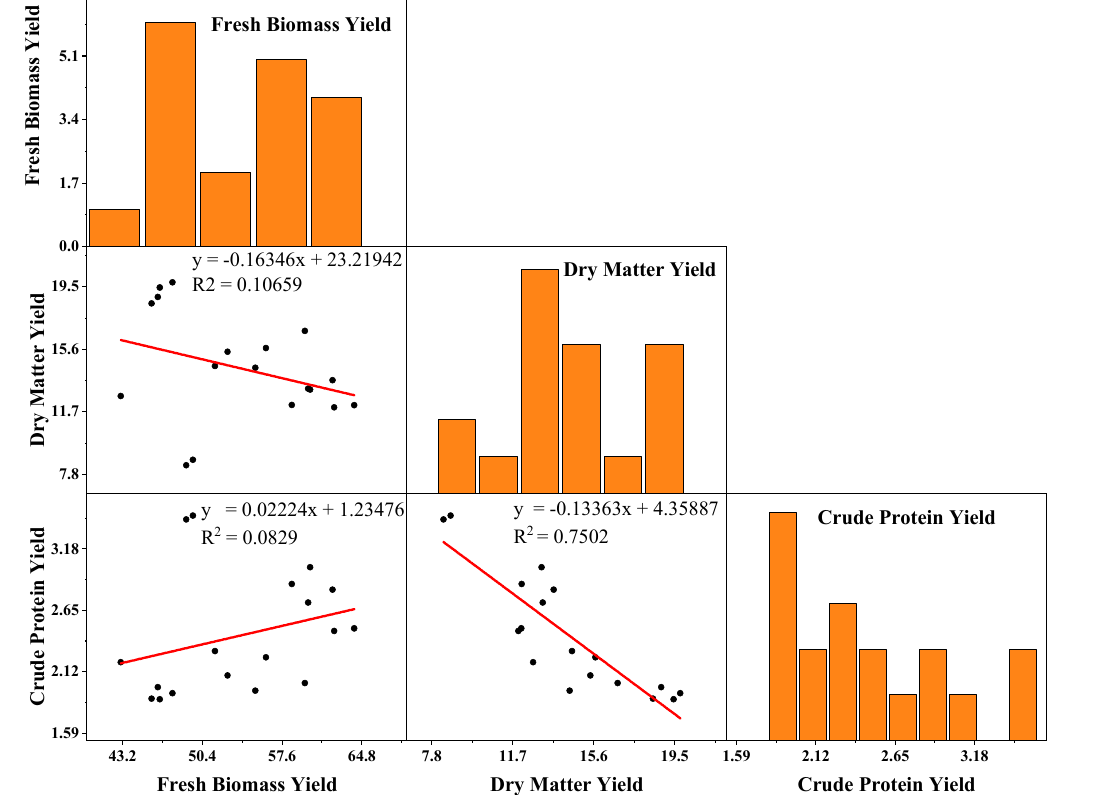
Figure 6. Scatterplot matrix including equation and regression values for pairwise correlation analyses between fresh biomass yield (FBY), dry matter yield (DMY), and crude protein yield (CPY) of forage conducted by wheat and ryegrass mono-cropping and wheat and ryegrass mixed cropping with alfalfa. Diagonal boxes showed histograms for each variable. The lower triangular matrix shows the relationship between a pair of variables.